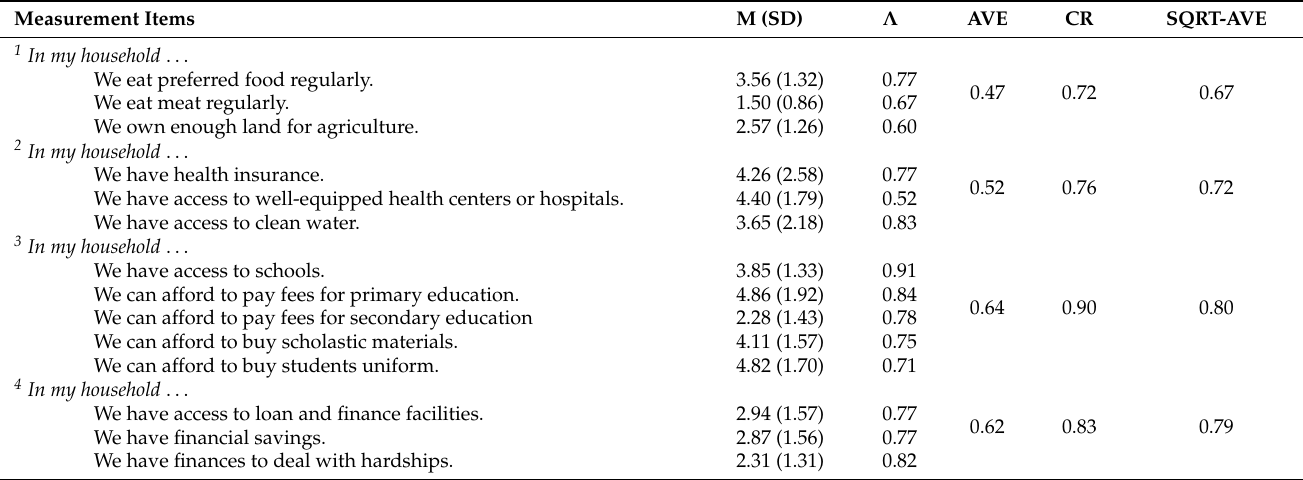
Table 1. Reliability of Household Livelihood Security